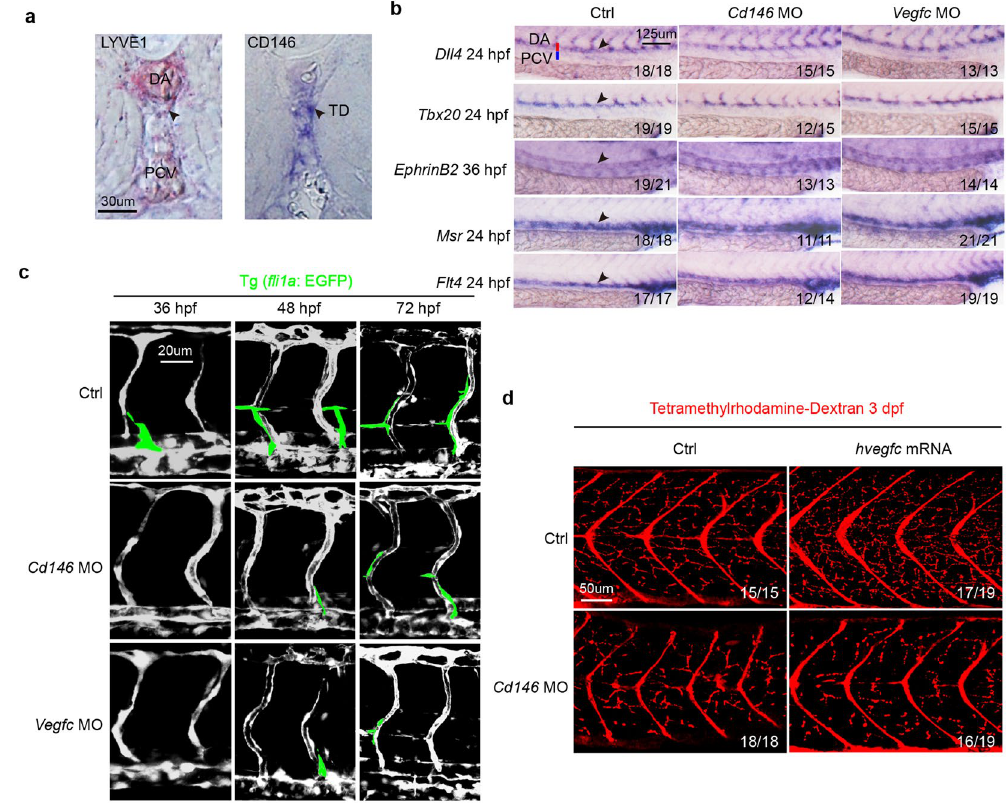
Figure 5. CD146 modulates VEGF-C induced lymphatic development in zebrafish. ( a ) CD146 expression in the zebrafish embryos at 5 dpf was detected by whole-mount in situ hybridization (WISH). lyve1b was used as positive control. Black arrows indicate the position of TD. DA, dorsal aorta; PCV, posterior cardinal vein; and TD, thoracic duct. Scale bars: 30 μ m. ( b ) The effect of knockdown cd146 or vegfc on blood vessels. Bright-field lateral views of the trunk of embryos injected with control, cd146 or vegfc specific MOs. Embryos were stained by WISH for a panel of arterial markers of dll4 , tbx20 and ephrinB2 and venous markers of msr and flt4 . Black arrows, blood vessels; DA, dorsal aorta; and PCV, posterior cardinal vein. Scale bars: 125 μ m. ( c ) The effect of knockdown cd146 or vegfc on vasculature of blood and lymph. The control, cd146 or vegfc specific MO were injected into the transgenic zebrafish Tg ( fli1a : EGFP) embryos, respectively. The embryos harvested at 36 hpf, 48 hpf and 72 hpf were analyzed. The confocal images were flanked by redrawing of the vessel contours. Transient lymphangiogenic structures (lymphangiogenic sprouts; PL cells) were labeled with light green. The other vessels (PCV, DA and ISV) were labeled with dark grey. Scale bars: 20 μ m. ( d ) The effects of cd146 knockdown on development of lymphatic capillary. The control or cd146 specific MO was co-injected with control or human vegfc mRNA into the transgenic zebrafish Tg ( fli1a : EGFP) embryos. Late-phase microangiography was used to visualize lymphatic capillaries in embryos at 3 dpf. Images showed the representative phenotypes of each group and the ratio indicated the embryos with such representative phenotype over the tested embryos. Scale bars: 50 μ